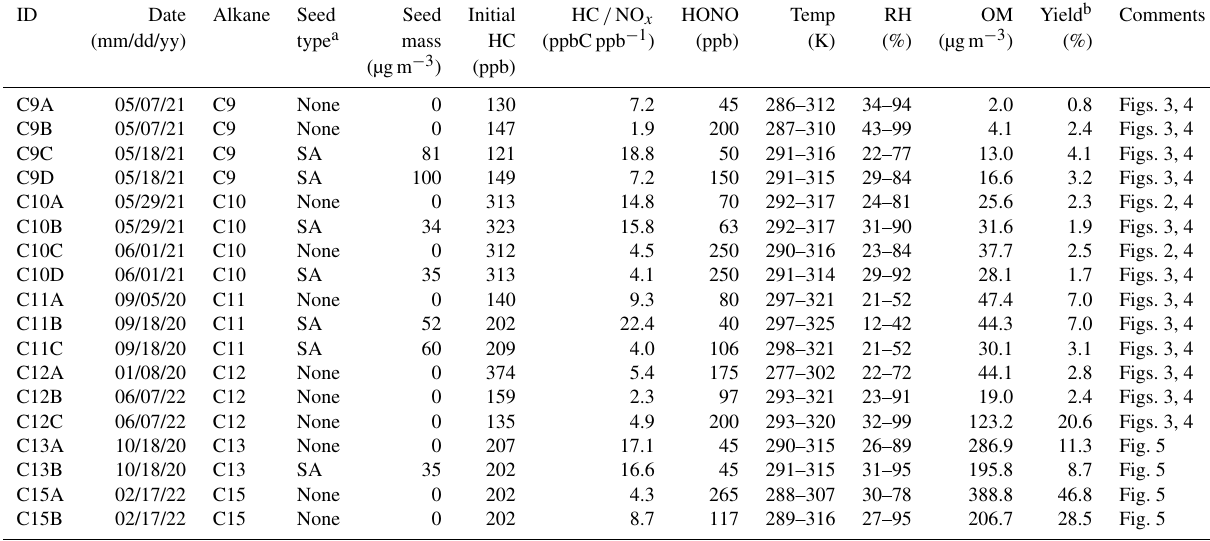
Table 1. Summary of experimental conditions and observed data for experiments performed in the UF-APHOR outdoor